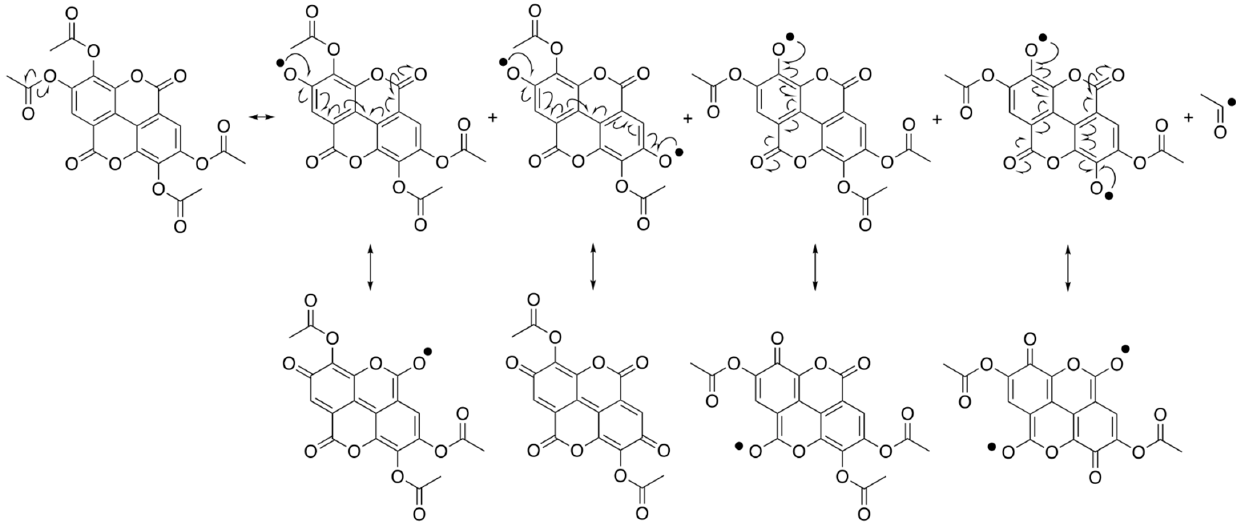
Scheme 1. Flow Chart showing the extensive resonance stabilization of the bis-coumarin phenoxyl radical obtained from EAPA.